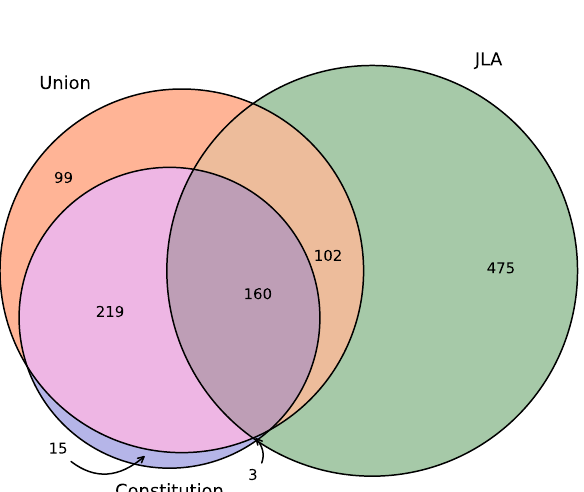
Fig. 1 Venn diagram of the three SNe Ia catalogs. Overlapped data points are shown as labeled numbers